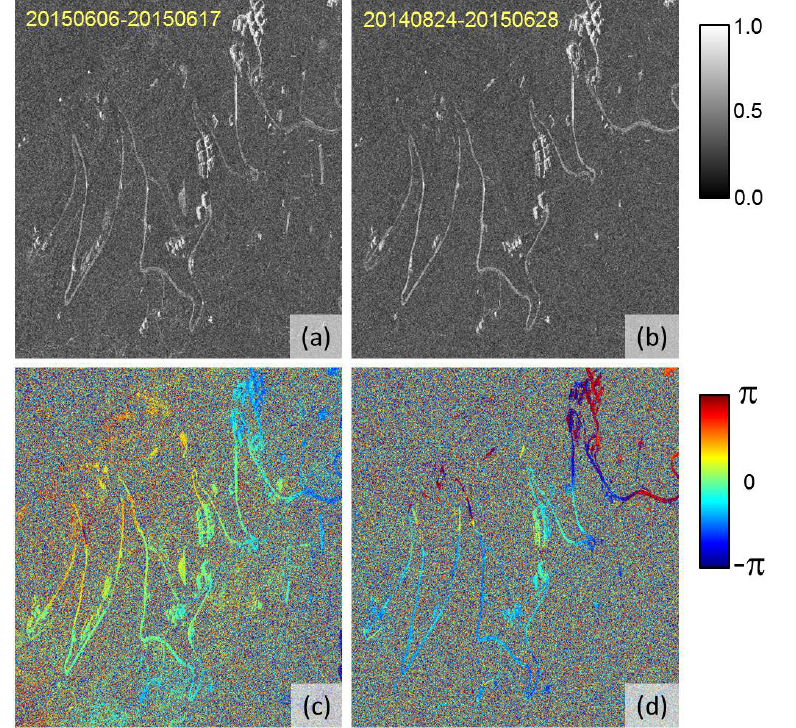
Figure 5. Coherence ( a , b ) and differential phase ( c , d ) of two interferograms with temporal baselines of 11 days ( a , c ) and 10 months ( b , d ) over the study area. Despite most of the pixels decorrelating very fast, the coherent ones are able preserve their phase quality very well along